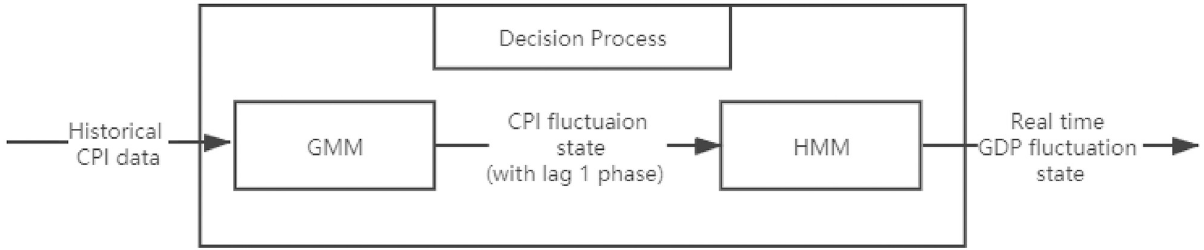
Fig 2. The decision process of the Gaussian Mixture Model-Hidden Markov Model (GMM-HMM) that introduces Gaussian Mixture Model (GMM) to transform CPI series into a categorical sequence.